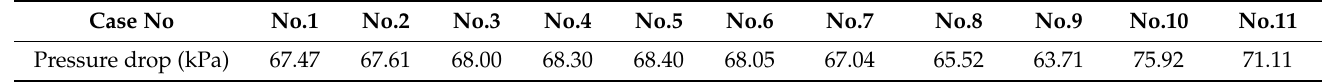
Table 3. Pressure drops of the heated section in different